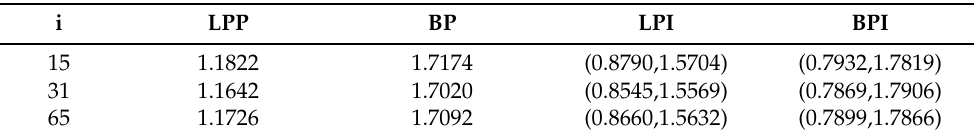
Table 10. Prediction under Diabetic retinopathy data.